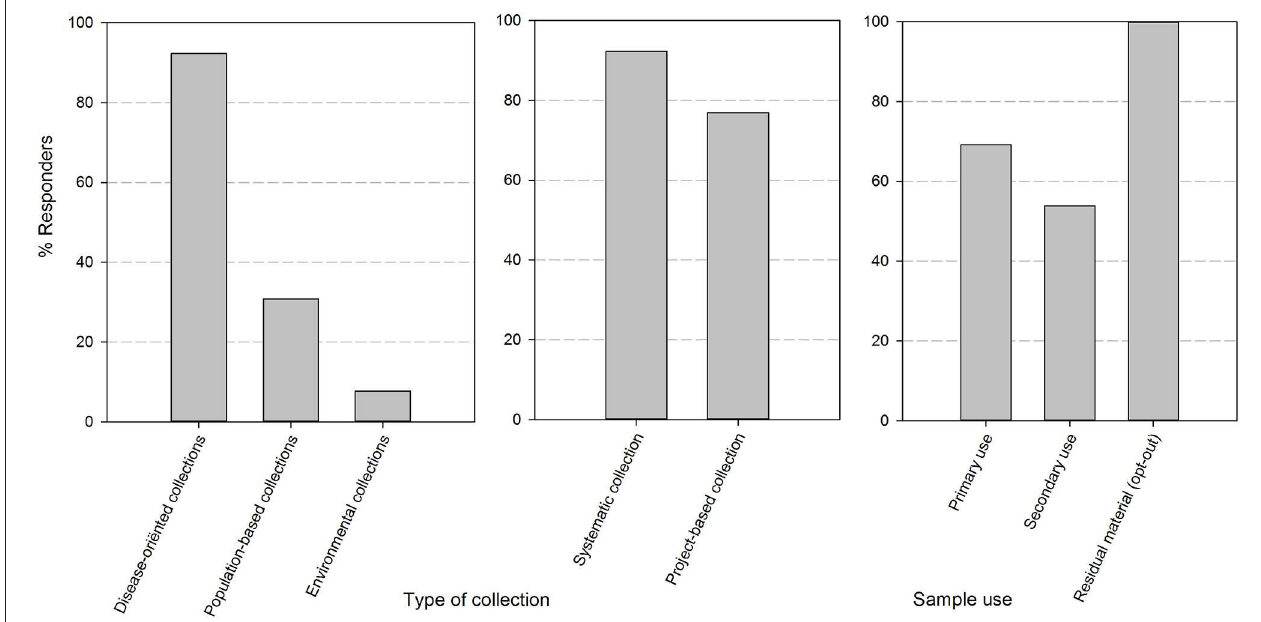
FIGURE 1 | The set-up and composition of human body material collections in biobanks of the BBMRI.be network. Responses were divided by the nature of the human body material collection (collection with a disease orientation, population-based or on environmental ground), by the method of collection of the material (systematic i.e., by sampling at occasions within the clinical path of the patient or project-based i.e., by sampling in the framework of a specific study/project at pre-defined and study-based time points) and by the type of use as defined in the Belgian legislation (primary use: the use to which the donor has explicitly consented to at the time of collection; secondary use: any other use than the one consented to at the time of collection; residuary material: the portion of human bodily material that has been taken from the donor for diagnostic or treatment purposes which, when a sufficient sample is safeguarded for refinement or completion of these purposes, is superfluous to these purposes and as such could be destroyed—presumed consent